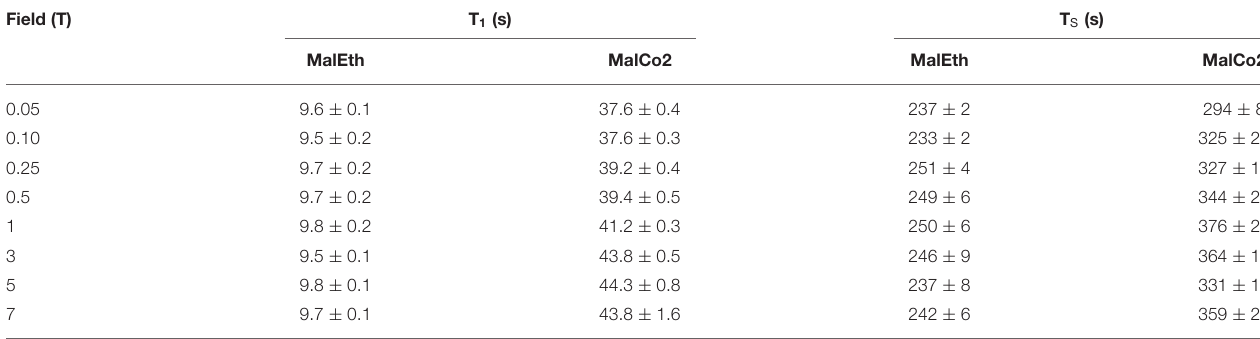
TABLE 5 | T 1 and T S values for samples MalEth and MalCo2 obtained at 20 ◦ C and different magnetic field strengths. Field (T)